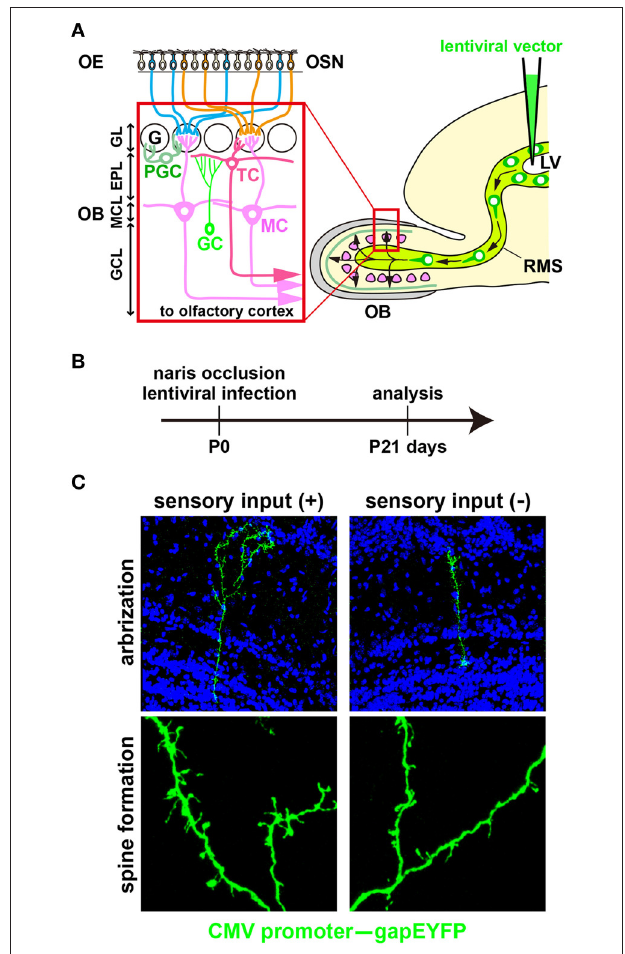
FIGURE 1 | Development of newborn OB interneurons is regulated by odor-evoked neural activity. (A) Schematic representation of the olfactory bulb neural circuitry. Olfactory bulb (OB) interneurons are generated throughout life in the subventricular zone of the lateral ventricle (LV), migrate along the rostral migratory stream (RMS), and differentiate into γ -aminobutyric acid (GABA)-releasing inhibitory interneurons such as granule cells (GCs) and periglomerular cells (PGCs) in the OB. GCs and PGCs modulate the neural activity of excitatory projection neurons, including mitral and tufted cells (MC and TC) through dendrodendritic synapses between inhibitory and excitatory neurons. EPL, external plexiform layer; G, glomerulus; GCL, granule cell layer; GL, glomerular layer; MCL, mitral cell layer; OE, olfactory epithelium; OSN, olfactory sensory neuron. (B) A lentiviral vector ( CMV promoter –gapEYFP gene) was injected into the lateral ventricle (LV) of wild-type mice at postnatal day 0 (P0). After 3 weeks (P21), YFP + interneurons can be visualized in the olfactory bulb (OB). The activity-dependent development of newborn interneurons was analyzed by injecting a lentivirus into the LV of unilaterally naris-occluded mice. (C) Newborn granule cells (GCs) were analyzed in the open and closed sides of the OB from P21 naris-occluded mice. GC dendrites are less branched and have lower spine density in the closed than in the open side of the OB (modified from Yoshihara et al., 2012, 2014).